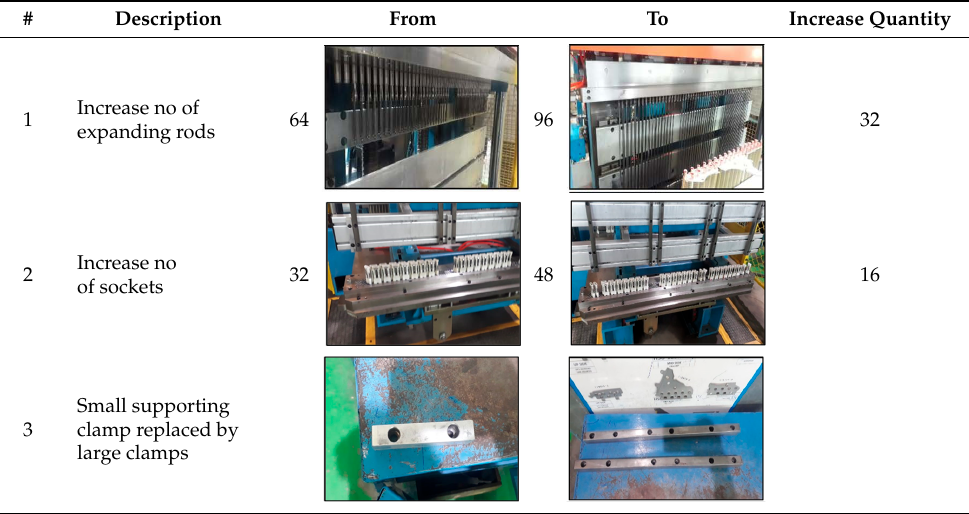
Table 7. Modifications in expanding machine.